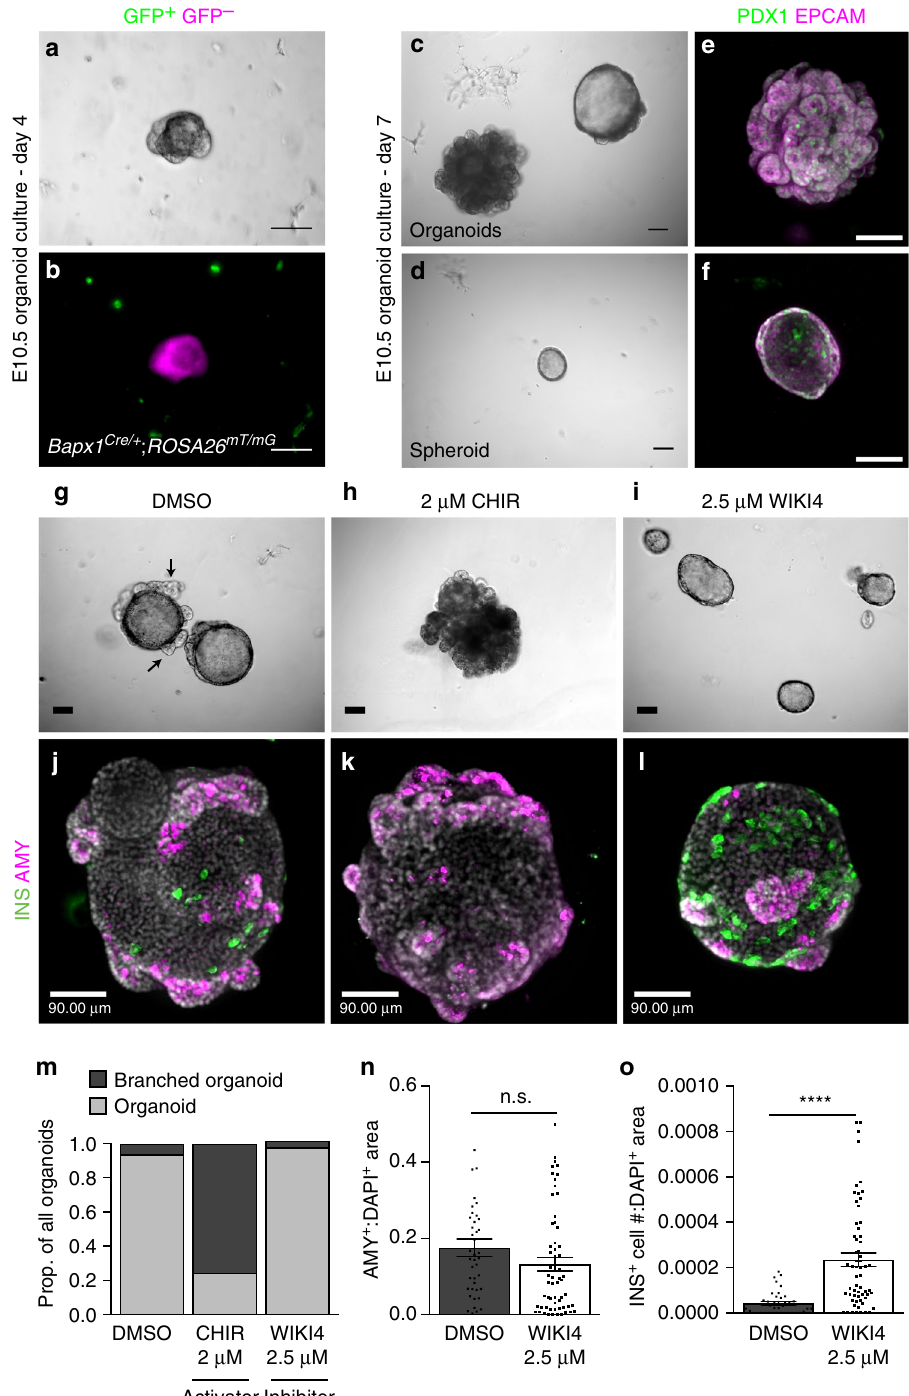
Fig. 6 WNT signaling inhibition boosts Insulin + cell development in epithelial organoids. a , b Representative bright fi eld ( a ) and fl uorescence microscopy ( b ) images of a forming organoid established from E10.5 Bapx1 Cre/ + ; ROSA26 mT/mG mesenchymal reporters demonstrates exclusion of GFP + Bapx1 -expressing mesenchyme. c , d Representative varieties of organoids at day 7 of culture are shown in c , with an extensively branched structure (left) and a more typical organoid (right). An undifferentiated spheroid is shown in d . e , f Organoid ( e ) and spheroid ( f ) structures formed in culture predominantly express epithelial marker, EPCAM, and pancreas marker, PDX1. g – i Morphology of organoids cultured in the presence of DMSO ( g ) vs. 2 µ M WNT activator, CHIR ( h ),